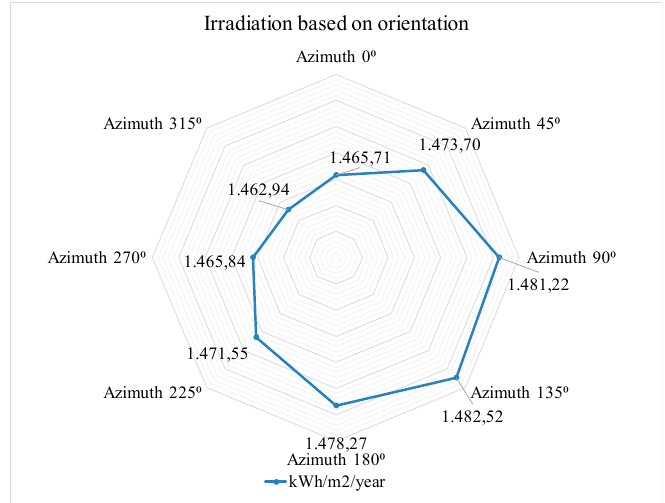
Figure 5. The average irradiation for different orientations. Figure 5 . The average irradiation for different orientations Figure 5 . The average irradiation for different orientations